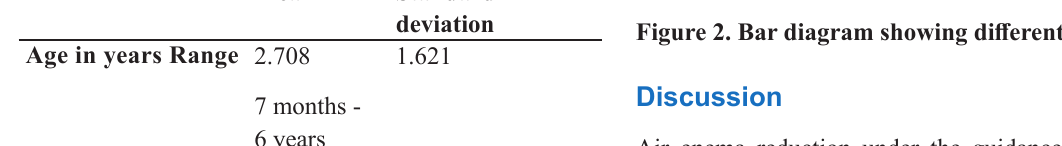
Table 1. Age distribution of subjects (N=12 ) Mean Standard deviation